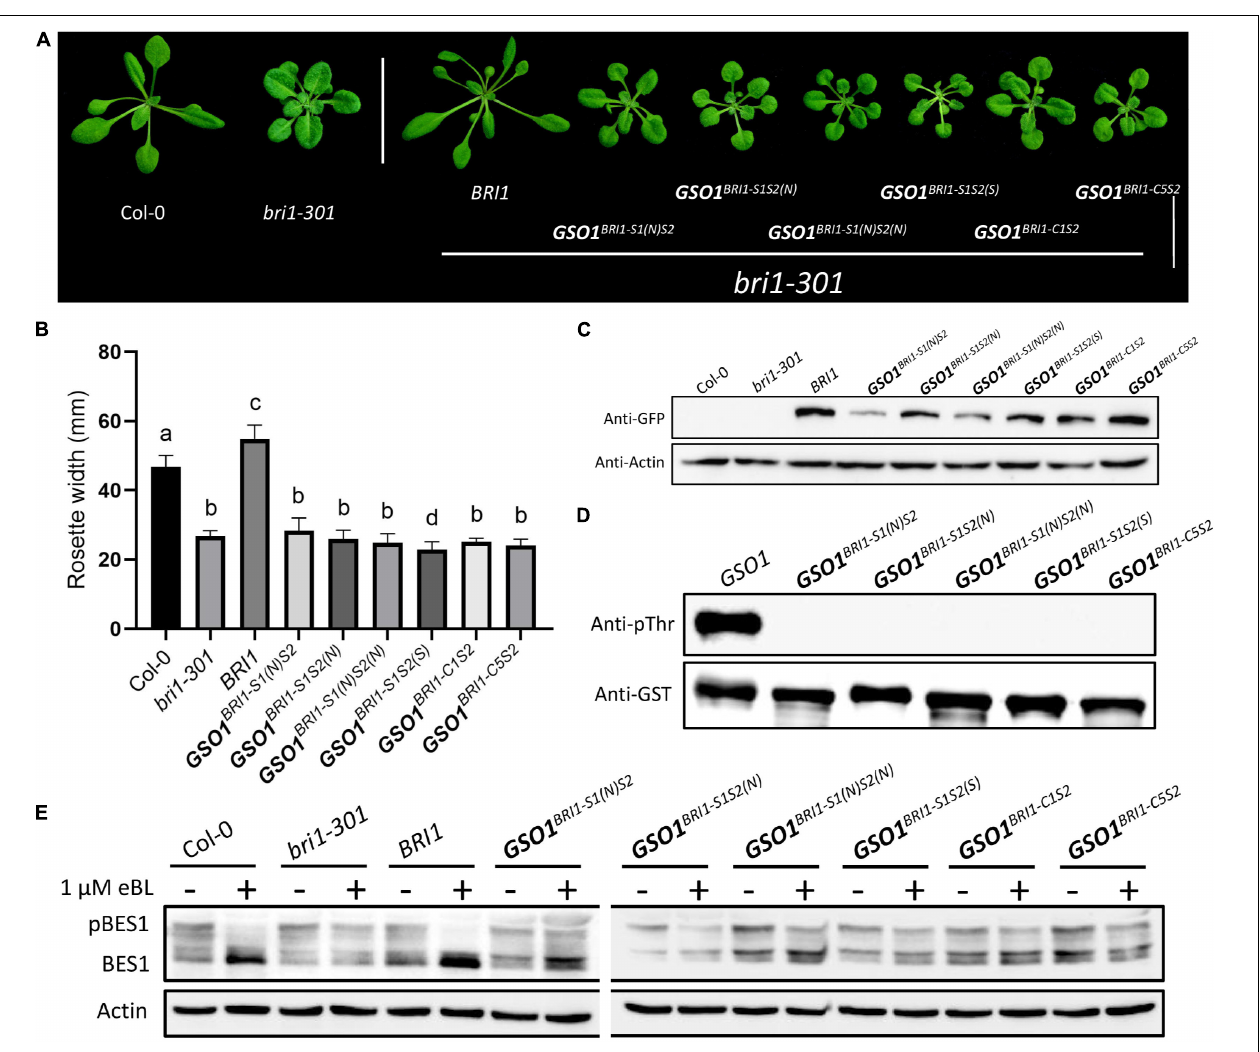
FIGURE 5 | Defining the necessary regions of S1 and S2. (A) Phenotypic expression of different chimeric BRI1-GSO1 transgenic lines that are different from the original motif-S1 and motif S2 in their sequence position on KD. The (N) represents the new sequence position whereas (S) represents the short segment on KD. Their specific sequence limits were marked in Supplementary Figure 6 . Scale bar = 2.0 cm. (B) Quantification of 4-week-old plants ( n = 13), p < 0.0001, one-way ANOVA with Tukey’s test. (C) The protein expression level of corresponding lines is shown. Actin served as a loading control. (D) In vitro kinase activity assay of GST-fused recombinant chimeric protein of GSO1 KD. (E) Immunoblotting of eBL induced dephosphorylation of BES1 in wild type, bri1-301 , BRI1, and chimeric lines in the bri1-301